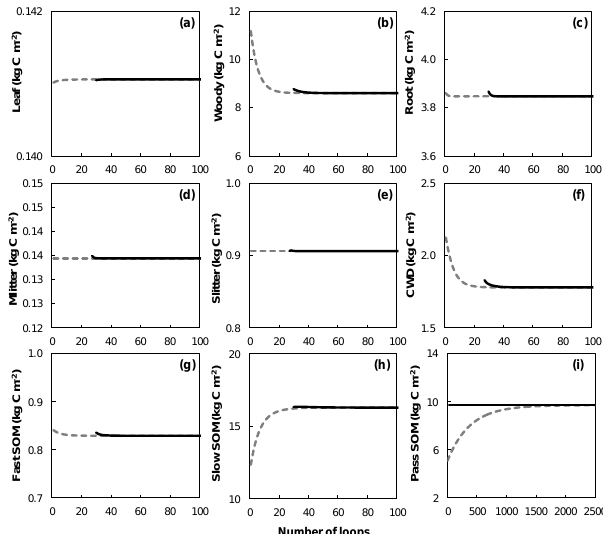
Figure 4. 720 Fig. 4. Carbon-only simulations: carbon state trajectories for all carbon pools at Harvard Forest site with different spin-up meth- ods from traditional procedure (dotted gray lines) and with the SAS (straight black lines).